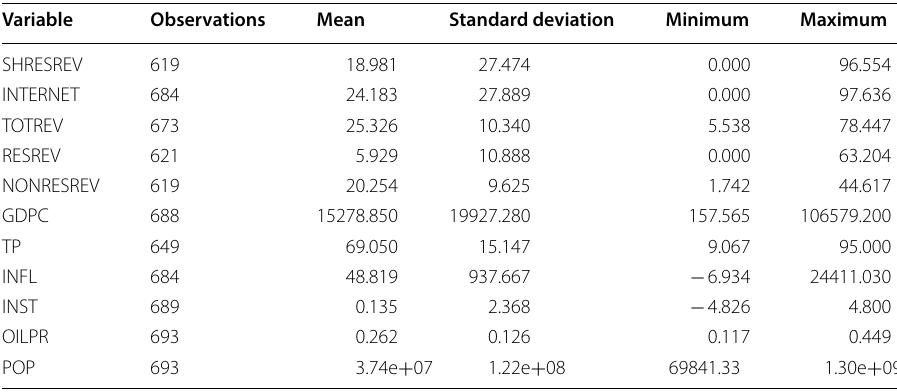
Table 9 Descriptive statistics on variables Variable